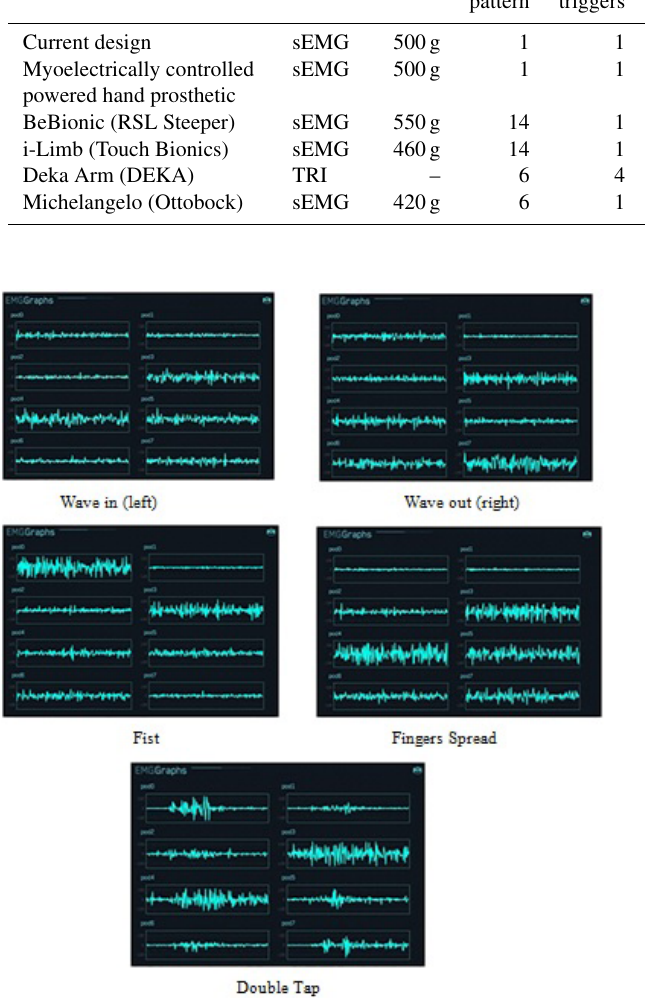
Figure 14. Results of the eight electromyography Myo armband sensors.